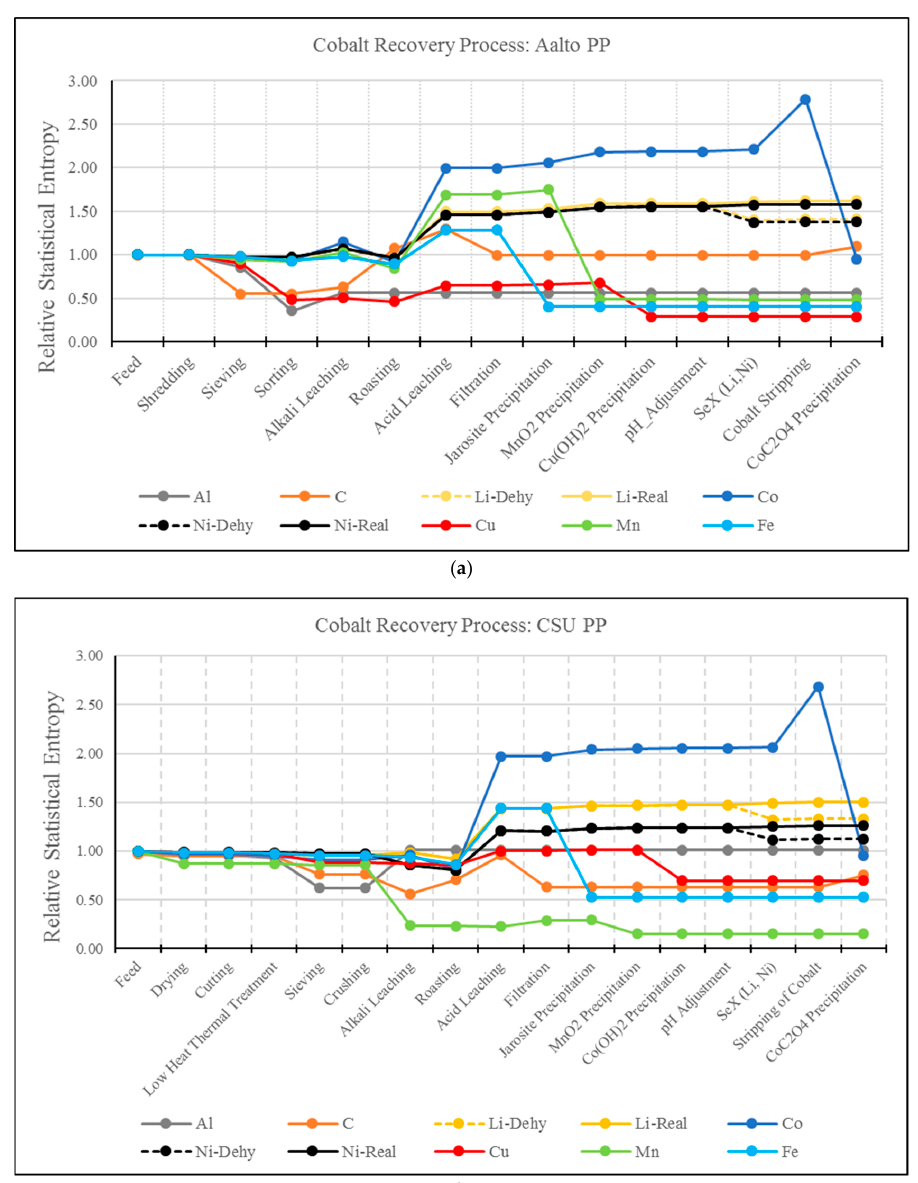
Figure 11. Electrode Treatment Loop. ( a ) Aalto pre-processing (PP); ( b ) Central South University (CSU) PP.